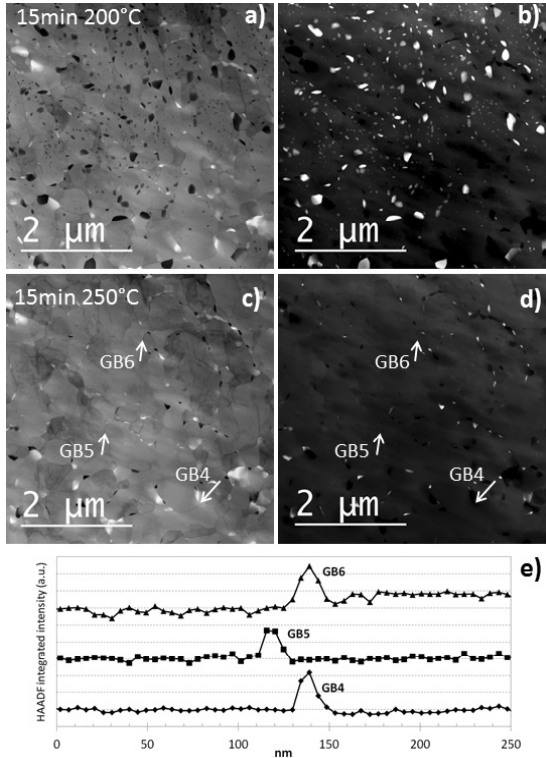
Fig. 3. (a, c) - STEM-BF and (b, d) - STEM-HAADF images showing the evolution of the microstructure of the Al-30Zn alloy processed by SPD followed by 15 min at 200 ° C and 15 additional minutes at 250 ° C (in-situ annealing showing the same region). (e) Line profiles computed across the three GBs pointed by arrows, and showing a significant increase of the HAADF signal that can be attributed to GB seg- regation of Zn or wetting layers at 250 ° C.